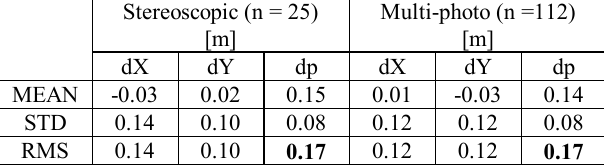
Table 2. Accuracies of photogrammetric methods compared to cadastral data